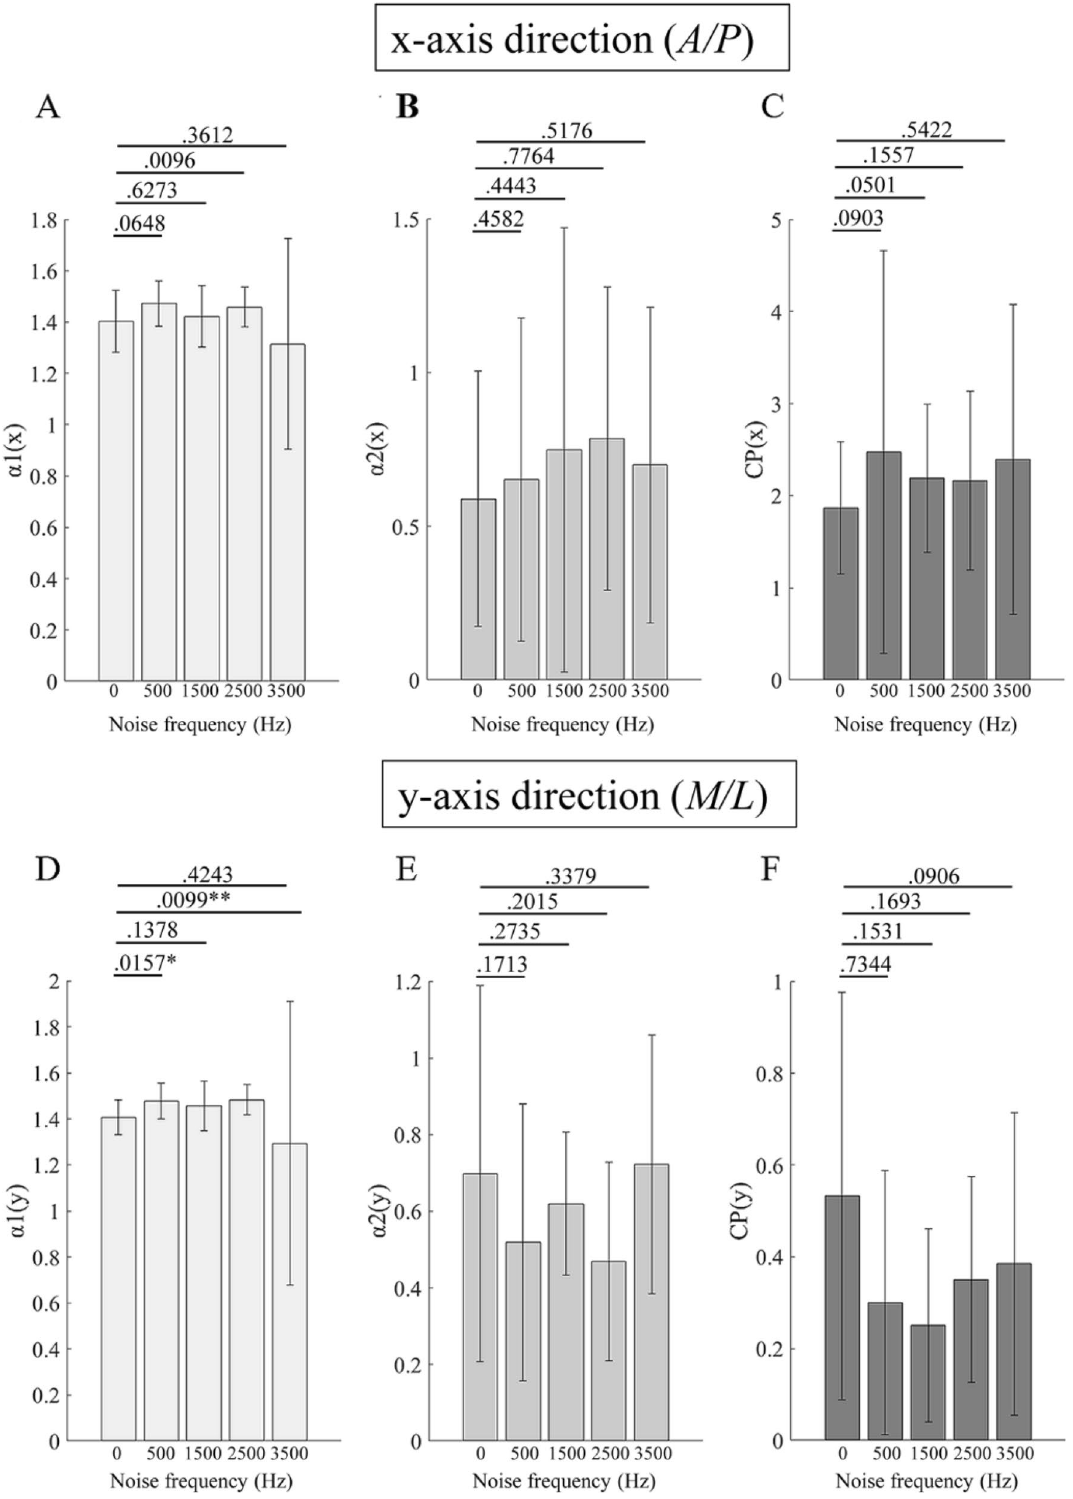
Figure 3. Fractal characteristics data of DFA stimulated with different WGN frequencies. ( A–C) are the data at x-axis ( A/P ) direction; ( D–F ) are the data at the y-axis ( M/L ) direction. ( A ) Short-term scaling index. ( B ) Long-term scaling index. ( C ) The intersection point between short-term and long-term fluctuations. ( D ) Short- term scaling index. ( E ) Long-term scaling index. ( F) The intersection point between short-term and long-term fluctuations. Data are presented as average ± standard deviation (SD); *means P < 0.05; **means P < 0.01. A/P, anterior/posterior; M/L, medial/lateral; CP, crossover point. Data of the images ( A – F ) were processed using Matlab (R2017a, https ://www.mathw orks.com/produ cts/new_produ cts/relea se201